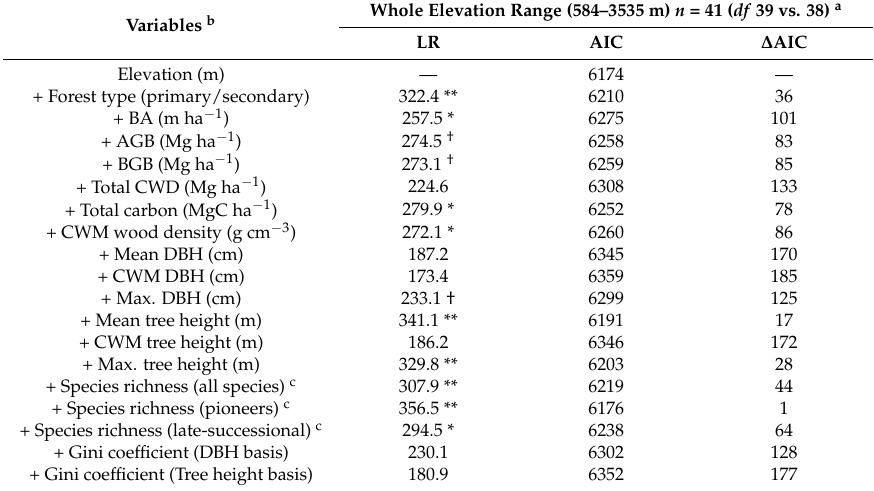
Table 3. Summary of model comparisons between elevation effect alone and elevation effect plus one of forest characteristics effects for a whole elevation range.